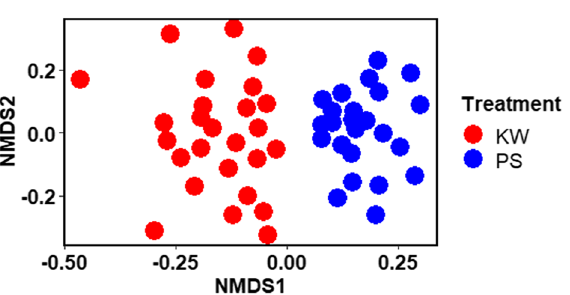
Figure 3. Non-metric multidimensional scaling (NMDS) ordination of Bray–Curtis distances between bacterial communities from permethrin-selected (PS) and parent strain (KW) of Aedes aegypti